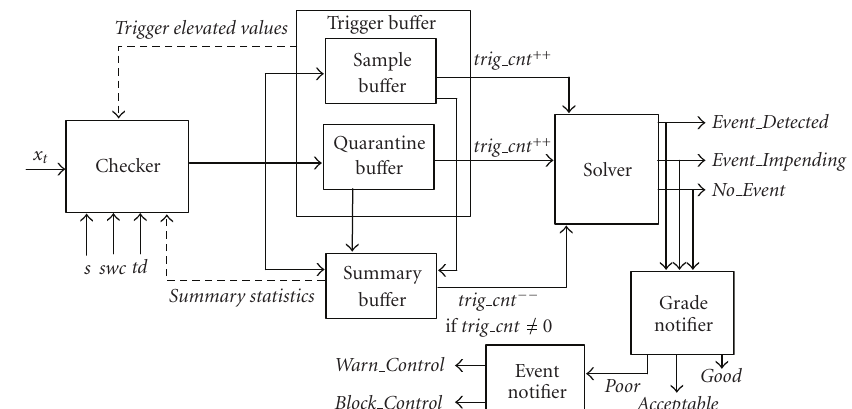
Figure 16: Plateau-detector block diagram.